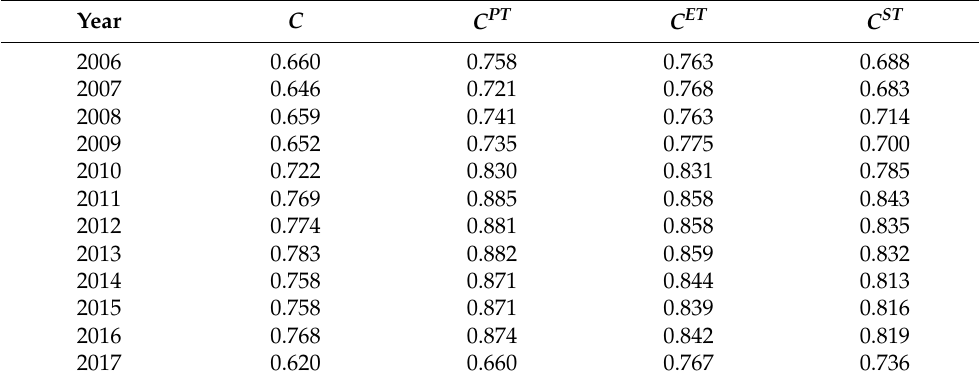
Table 5. Coupling degree between urbanization and rail